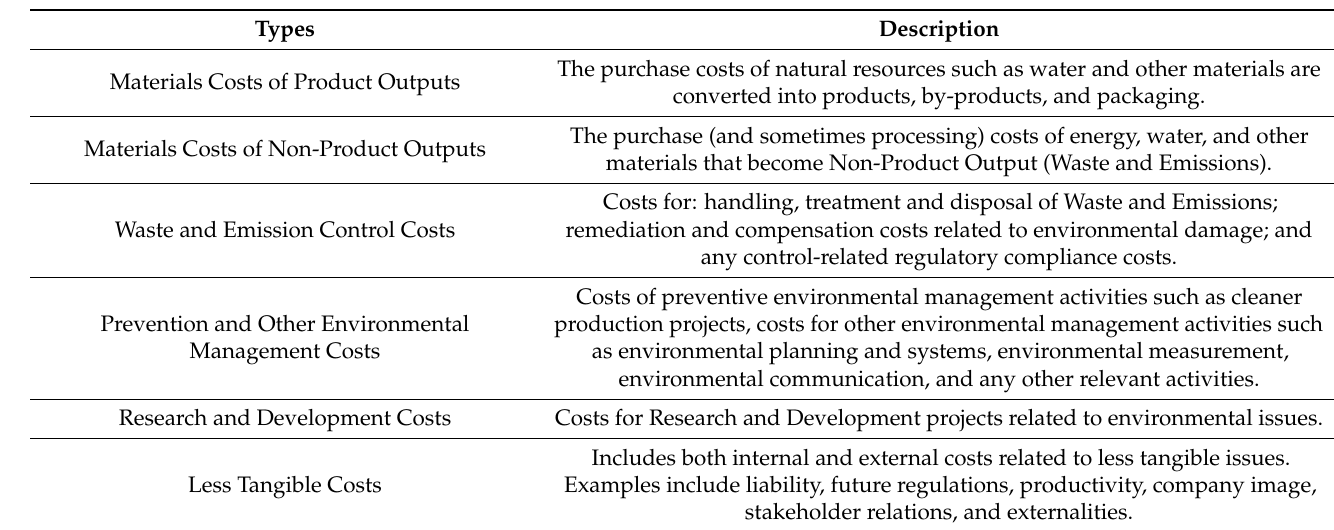
Table 1. Cost categories for